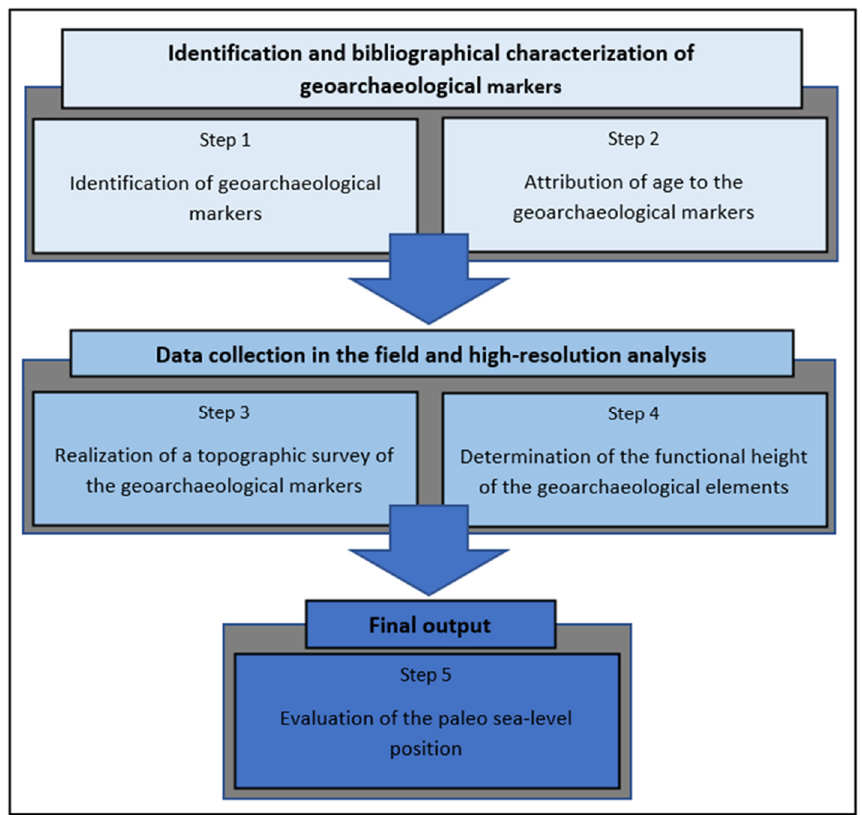
Figure 3. Steps of the proposed methodological analysis procedure to evaluate the paleo sea-level position using geoarchaeological markers.